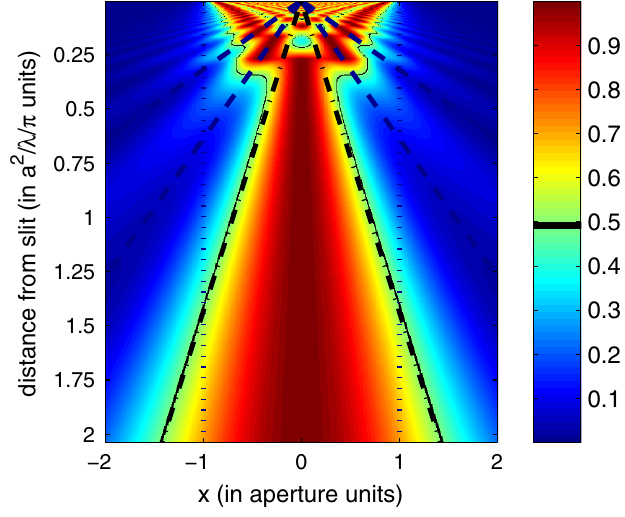
FIG. 5. Geometry of the square aperture for the calculation of the Fresnel